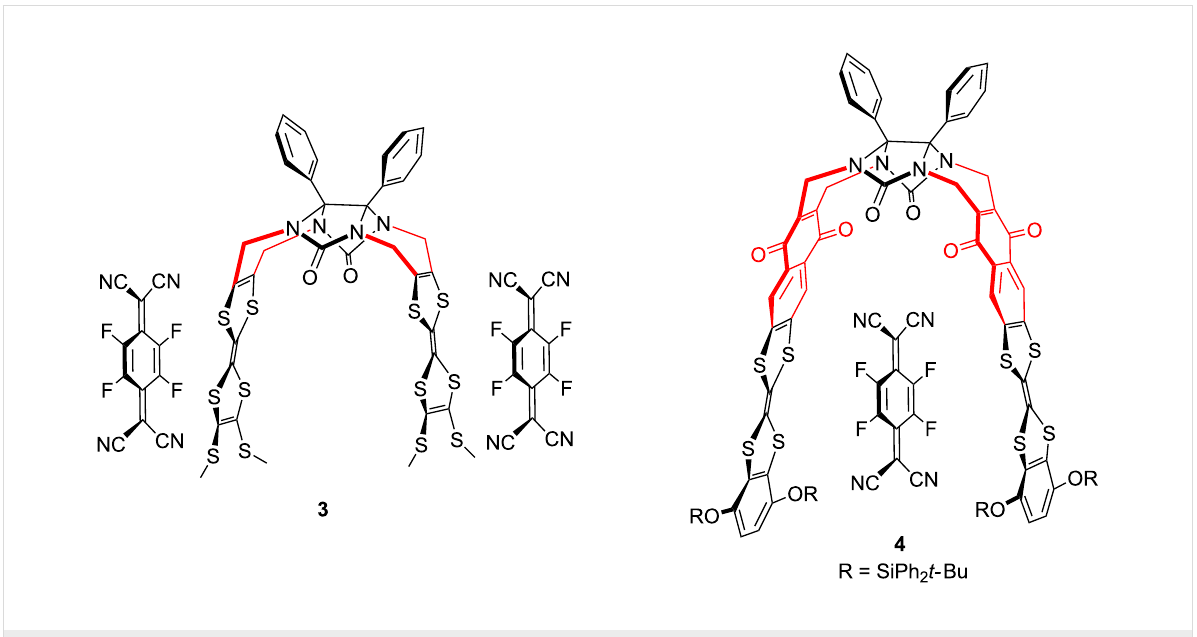
Figure 11: Redox interaction (left) and complexation (right) of F 4 -TCNQ with molecular clips 3 and 4 .